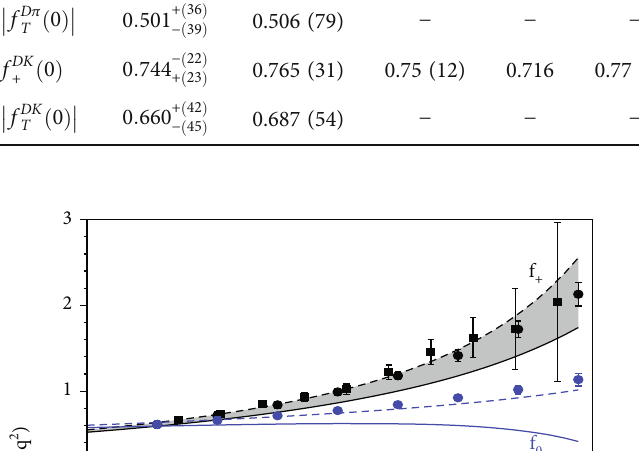
∣ = 0 : 660 + ð 42 Þ − ð 45 Þ agree with f